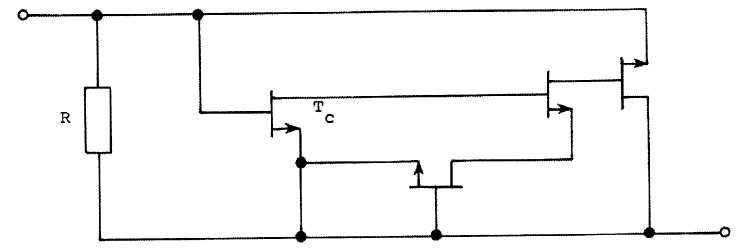
FIGURE 5 Zhang active inductor with